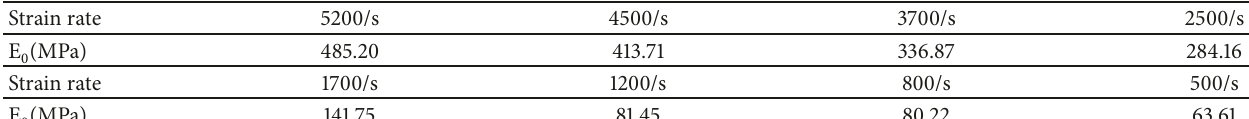
Table 1: Initial elastic modulus under different strain rate.